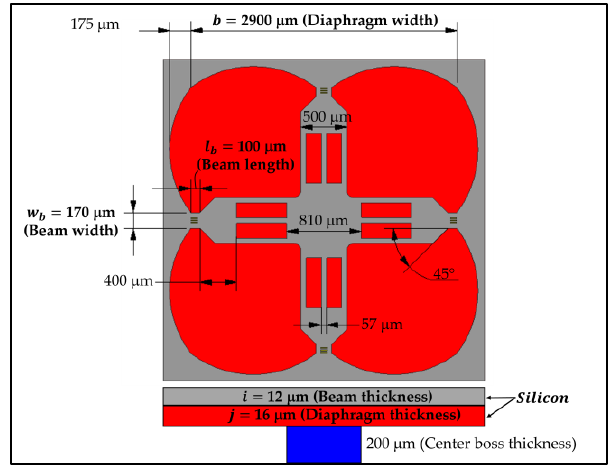
Figure 1. MEMS piezoresistive pressure sensor for ultra-low pressure measurements with optimized geometric parameters, proposed by Thawornsathit et al. (2022) [40] .